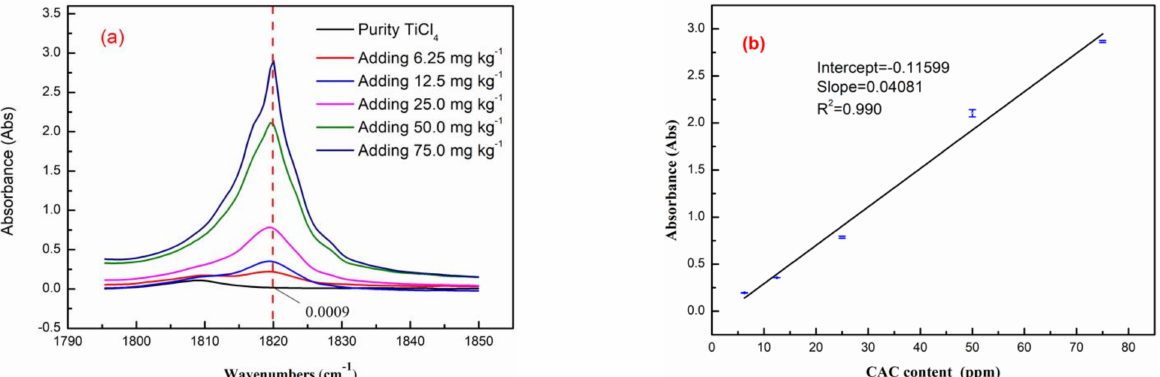
Figure 5. ( a ) The changes in characteristic peaks of FTIR spectra with increasing CAC content and ( b ) the relationship between the peak intensity and CAC